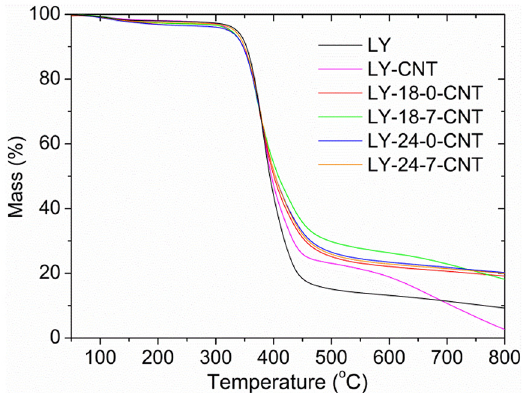
Figure 5. TGA thermograms of hybrid